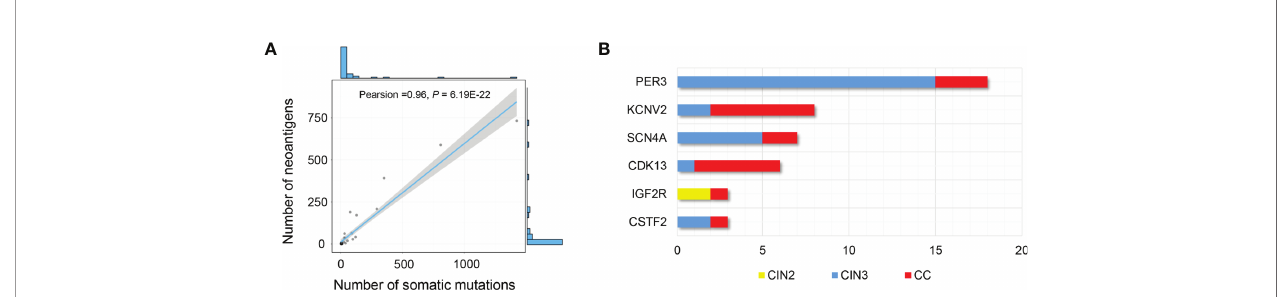
FIGURE 5 | Distribution of potential neoepitopes genes during stepwise cervical carcinogenesis. (A) Correlation between the number of mutations and the number of exome-derived neoepitopes (Pearson ’ s correlation coef fi cient, r = 0.96, P = 6.19E-22). (B) Barplots showed the number of PNeoGs in both CINs and